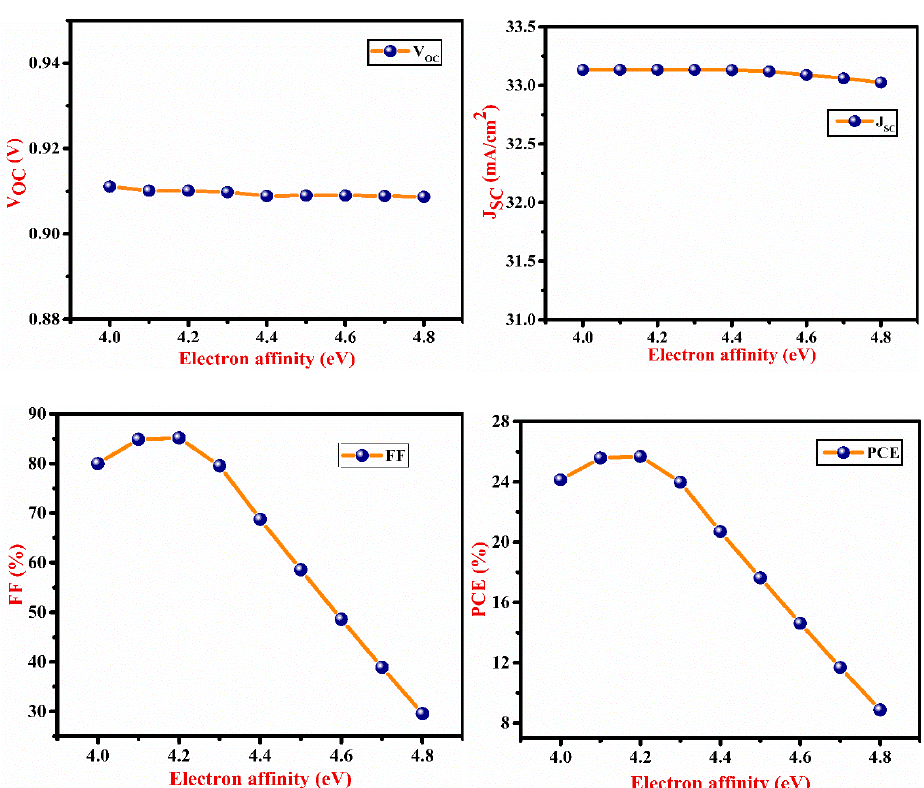
Figure 5. Impact of the electron affinity of SnS layer on V OC , J SC , FF and PCE of the proposed cell. Table 3. Comparison of previously reported results to proposed work.